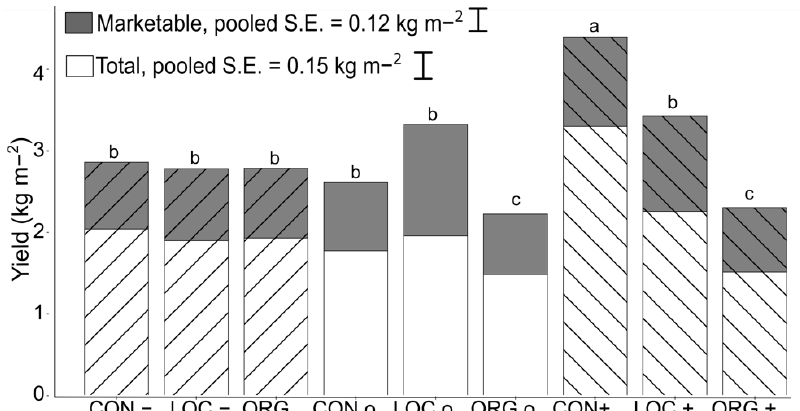
Figure 8. Total yield and marketable yield of “Jewel” strawberry for various management practices. Fruits were collected between 19 June and 10 July 2019. Management regimes: Conventional (CON), Organic (ORG), and Low Carbon Conventional (LOC). Treatments fertilized with 50 kg N ha − 1 ( − ), cross hatch up to right, 100 kg ha − 1 N (o), no cross hatch, or 100 kg N ha − 1 with intensive application of biological supplements (+), cross hatch down to right. Differences between treatments calculated using Tukey’s HSD, where differences in marketable yield were significant at p = 0.094, and differences in total yield significant at p = 0.05. Letters indicating significance are identical for both total and marketable yields. S.E. = standard error of the mean.